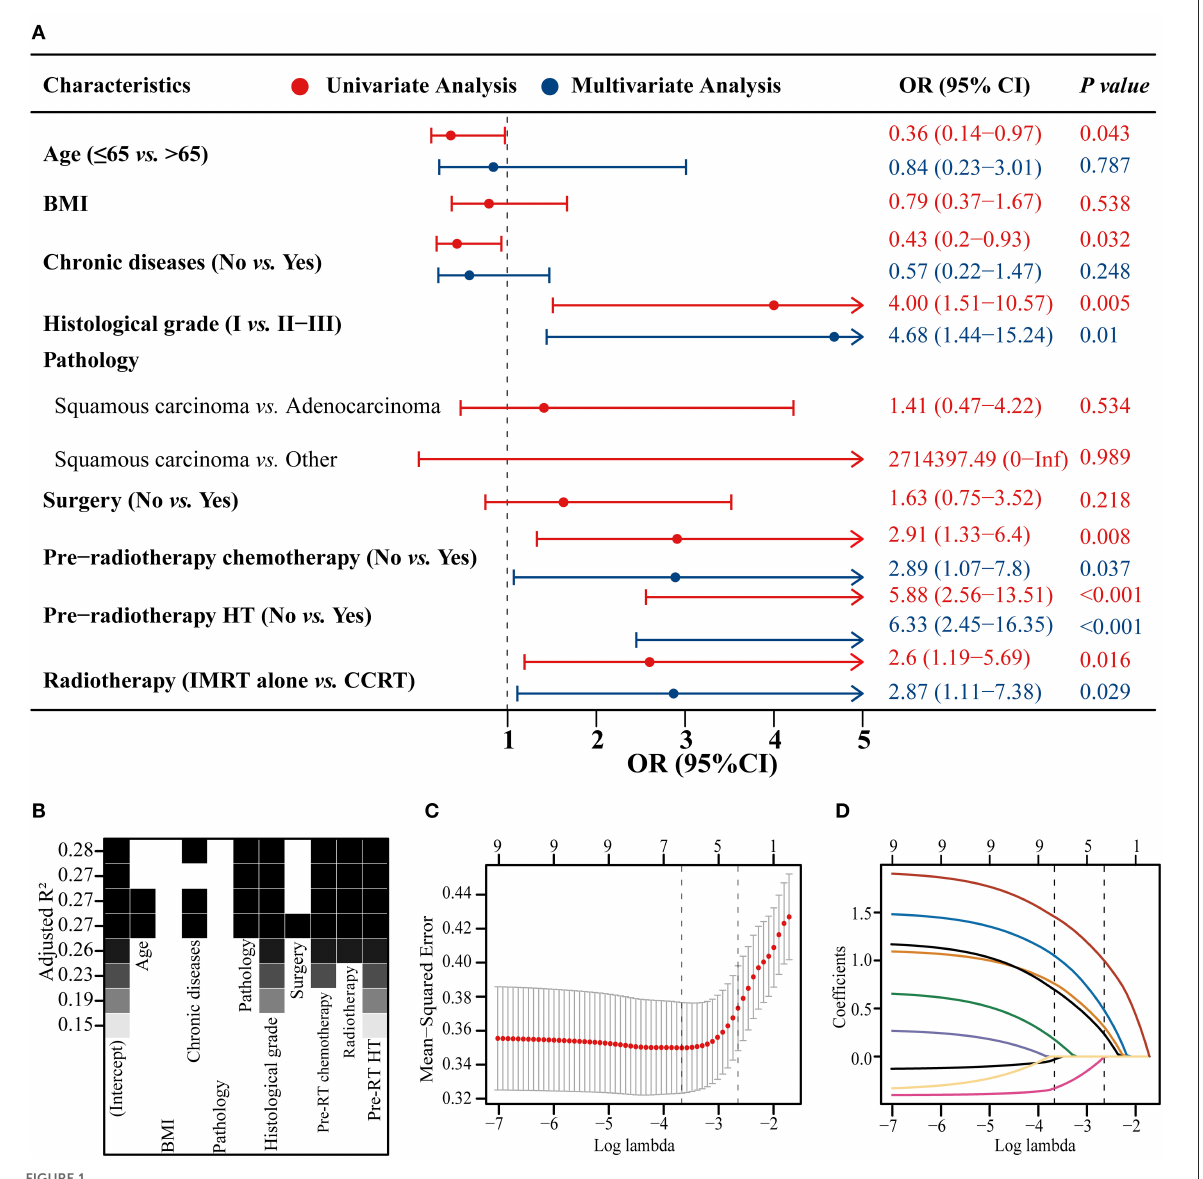
median value of the C-index was 0.80 (IQR: 0.73–0.85), and the Brier score was 0.16 (IQR: 0.14–0.20) (Figure 5D).